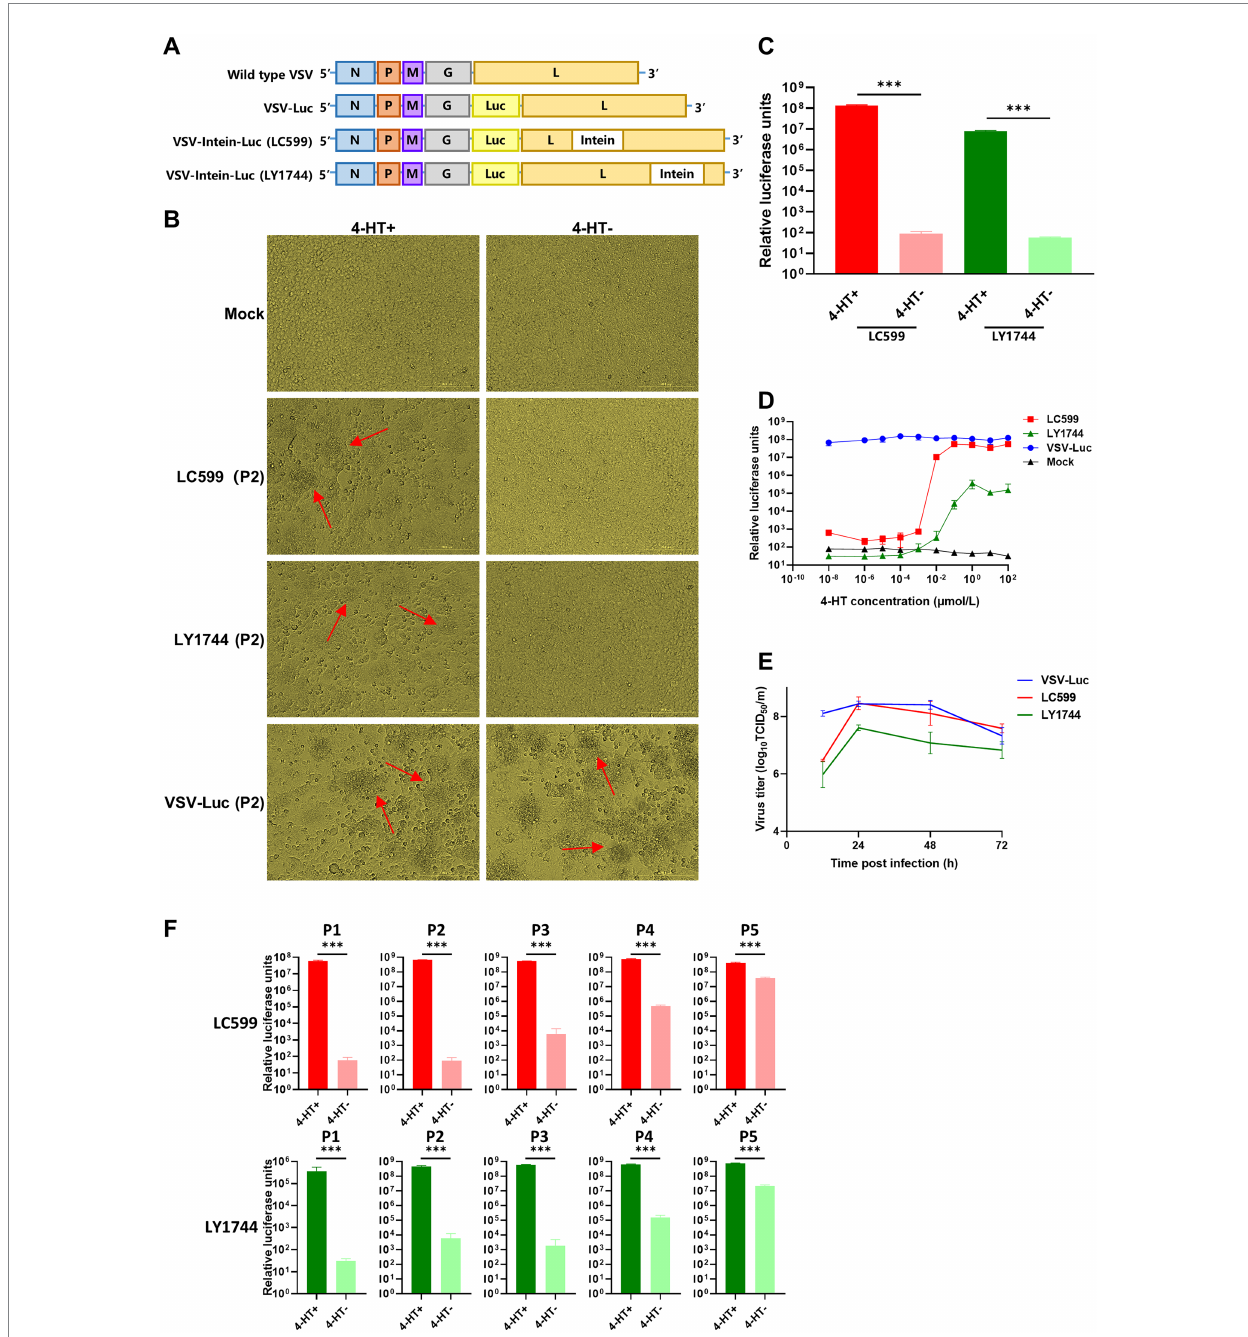
FIGURE 3 Characterization of the replication of the intein-inserted VSV in cells. (A) Virus genome schemes of VSVs: wild type VSV, VSV-Luc, LC599, and LY1744. (B) Cell morphology of BHK-T7 cells infected by LC599 (P2) and LY1744 (P2). The 4-HT + group could form syncytia mediated by the expression of VSV G protein (red arrow). (C) 4-HT regulated the replication of LC599 (P2) and LY1744 (P2) in a dose-dependent manner. (D) The replication of LC599 (P2) and LY1744 (P2) with or without 4-HT. (E) The growth curve of VSV-Luc, LC599, and LY1744. (F) BHK-T7 cells were infected with P1 generation recombinant virus (4-HT + ), and the culture supernatant harvested post-infection was defined as P2 generation. The culture supernatant harvested post-infection with P2 generation (4-HT + ) was defined as P3 generation and so on. The 4-HT-regulated capacity on different passages of LC599 and LY1744 was detected. Significance of results were evaluated by Mann Whitney test between two groups. p value less than 0.05 was considered significant. * p < 0.05; ** p < 0.01; *** p < 0.001; n.s., not